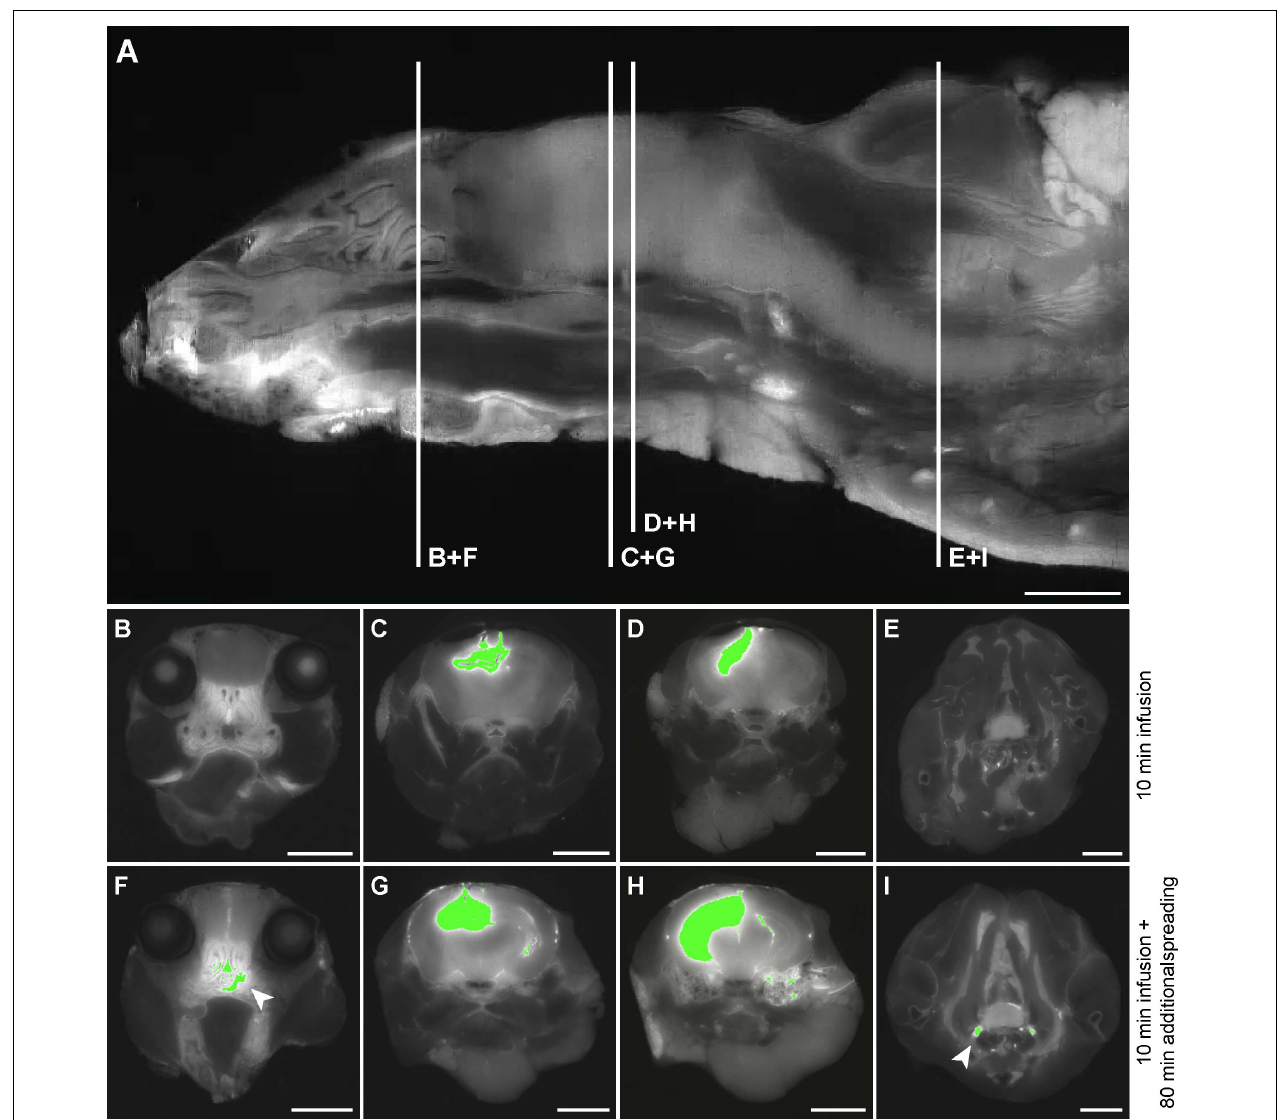
FIGURE 2 | Detail images of tracer dispersion to different anatomical structures. (A) A sagittal view of the imaged volume of the mouse. The vertical lines indicate the positions of relevant anatomical structures as shown in the axial views of the mouse in (B–I) . Panels (B–E) demonstrate segmentation of the fluorescein labeled tracer above the fixed intensity threshold in a mouse sacrificed directly after infusion, while (F–I) show this for a mouse that was sacrificed after an additional spreading period of 80 min. (B) and (F) indicate tracer presence in the nasal turbinates, (C) and (G) demonstrate this for the infusion site in the CA3 region of the hippocampus, (D) and (H) for the hippocampus caudal to the infusion site, and (E) and (I) for the spinal nerves. The arrows indicate tracer dispersion to the nasal turbinates and spinal nerves in (F) and (I) , respectively. Scale bar represents 3500 µ